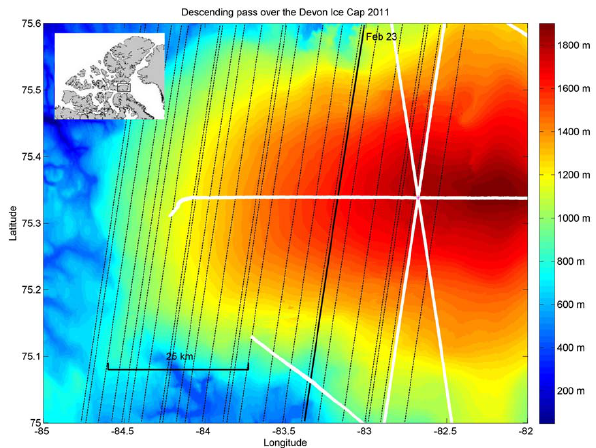
Fig. 4. The western part of the Devon Ice Cap with topography illustrated in colour. The sub-satellite position of the 23 February descending pass is shown as a black line and the positions of the airborne laser scanning altimeter data are shown in white. The dotted black lines indicate the sub-satellite tracks of the 25 descending passes which were used to create the DEM illustrated in Fig. 8. The position of the Devon Ice Cap in the Canadian Arctic is shown in the insert. In this figure the topography is derived from the Canadian digital elevation database merged with the CS swath processed results shown in Figure 8.